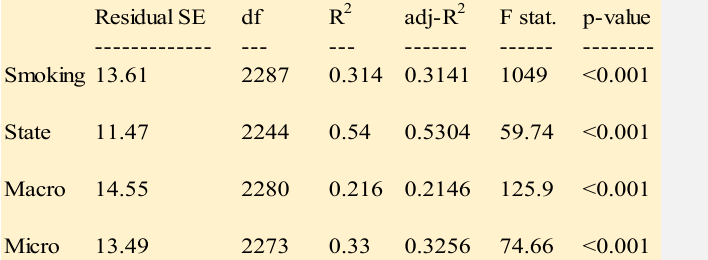
Figure 6. All Regression Models. Significance codes: 0 ‘***’ 0.001 ‘**’ 0.01 ‘*’ 0.05 ‘.’ 0.1 ‘ ’ 1. Smoking is a very strong predictor of lung cancer. For every percentage increase in adult smoking, the number of lung cancer cases increases by 164.583 per 100,000 citizens. The variance explained (adj. R 2 ) is 0.3141.